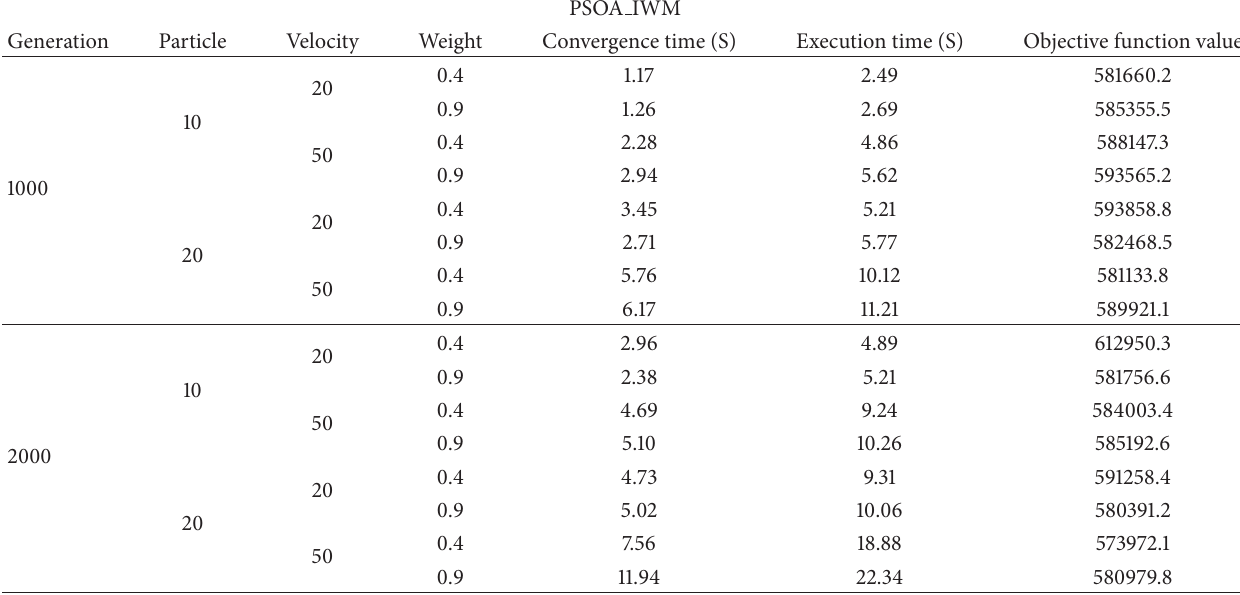
Table 3: Experimental design results of PSOA IWM with different groups of parameters. PSOA